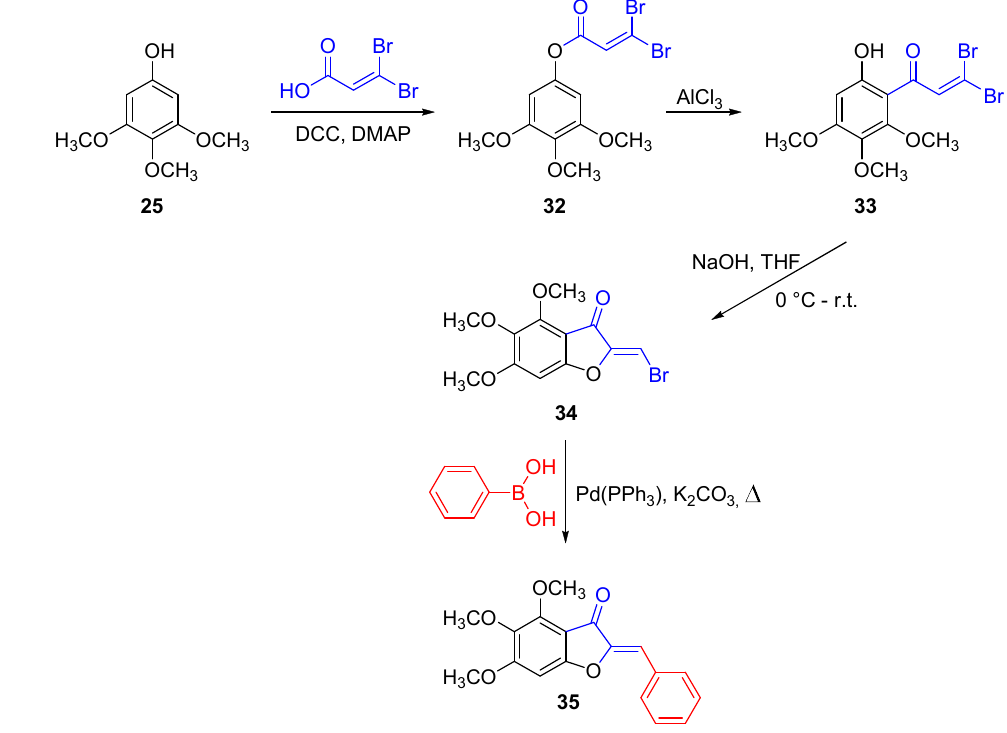
Scheme 3. Synthesis of 4,5,6-trimethoxyaurone according to Kraus and Gupta [57].